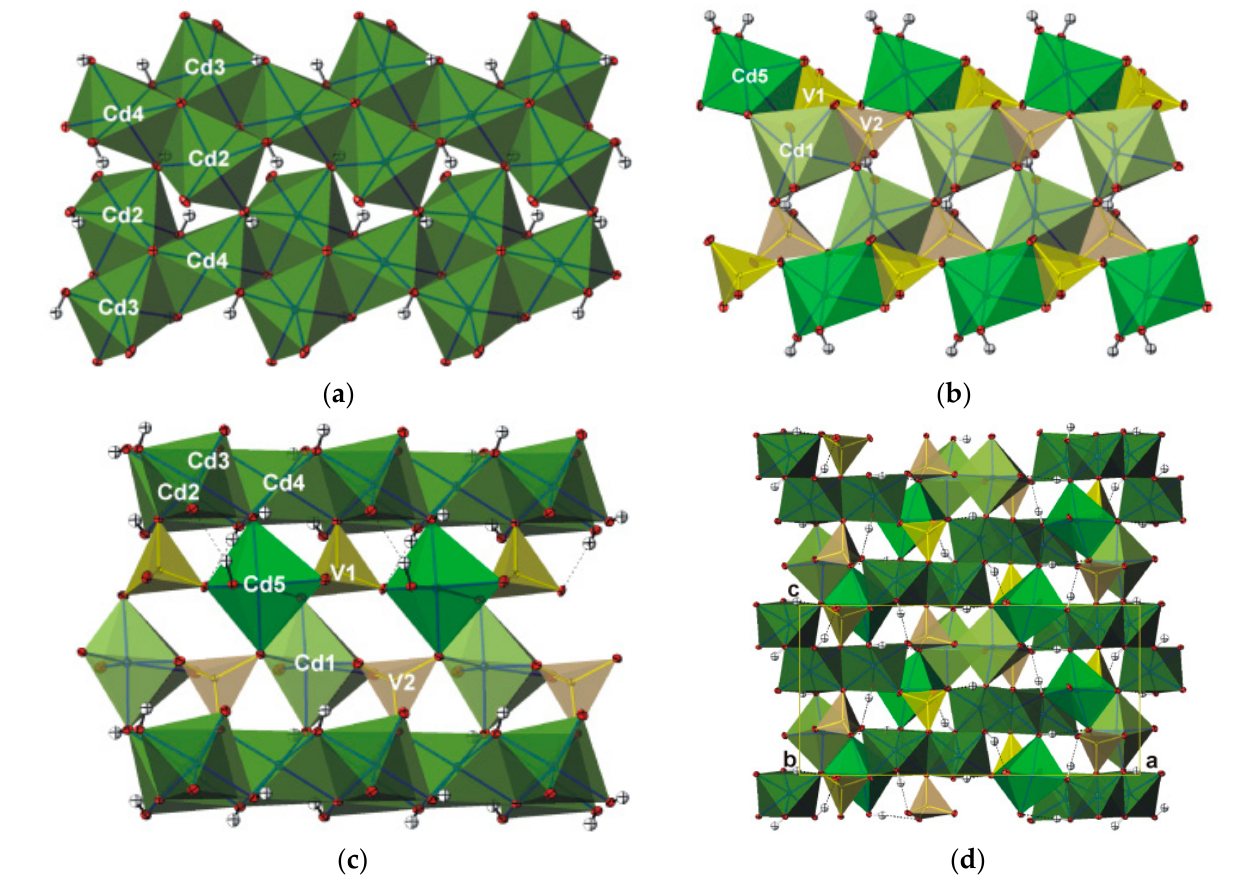
Figure 2. The linkage of two octahedral ribbons of M (O,OH) 6 octahedra ( M = Cd2, Cd3, Cd4) via O3 in the projection approximately along the [101] ( b -axis is horizontal). Small grey spheres represent H atoms ( a ). The linkage of neighboring double chains of coupled VO 4 tetrahedra and M (O,OH) 6 octahedra ( M = Cd1, Cd5) via O8 in the projection along the [104] ( b -axis is horizontal) ( b ). The double ribbons of M (O,OH) 6 octahedra ( M = Cd2, Cd3, Cd4) connected by pairs of coupled VO 4 tetrahedra and M (O,OH) 6 octahedra ( M = Cd1, Cd5) ( c ). The projection of the structure along the [010] direction ( d ).